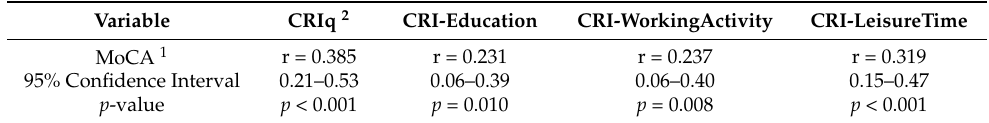
Table 4. Correlation analyses between CRIq score and MoCA scores.